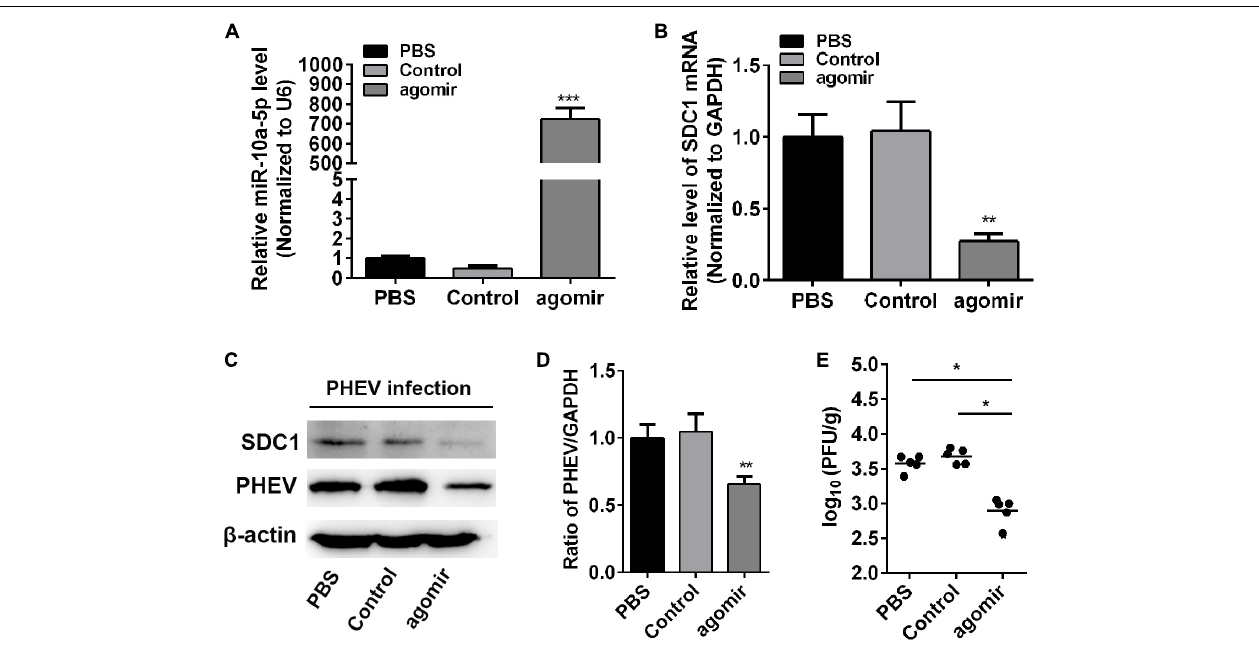
FIGURE 6 | MiR-10a-5p agomir reduced porcine hemagglutinating encephalomyelitis virus (PHEV) replication in vivo . BALB/c mice were injected with miR-10a-5p agomir at 1 and 3 days post infection following PHEV infection. N = 6 mice per group, three independent experiments. The brain tissues were collected, and qRT-PCR and western blotting assay were performed to assess miR-10a-5p miRNA level (A) , Syndecan 1 (SDC1) mRNA transcription (B) , SDC1 protein expression (C) , and viral replication and load (C,D) . Phosphate-buffered saline (PBS)-injected mice were identified as mock injection, whereas mice in the control group were only infected with PHEV without agomir or PBS injection. (E) The titer of infectious virus in brain were measured by using a standard plaque assay in N2a cells. Data are shown as means ± SD of at least three independent experiments. * p < 0.05; ** p < 0.01; *** p <